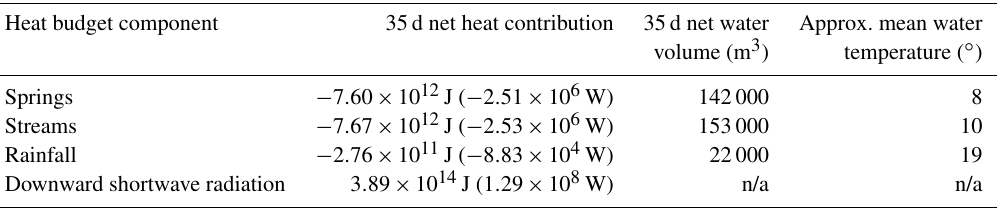
Figure 5. Simplified workflow and results describing the area and discharge analyses of Spring 8 (included in Table S2 and Fig. S6) using the Basin Head plume size–spring discharge relationship. (a) Raw thermal image of Spring 8 cropped (rectangular) to the spring area (maximum offset of 14 ◦ between the spring water and discharge environment; pixel resolution of 6cm per pixel). (b) Thermal image converted to 8-bit grayscale and cropped (polygonal) to thermal groups of interest. (c) Graph of thermal image pixel data in terms of cumulative area and binned grayscale values. The graphical analysis method of Roseen (2002) guided by manual inspection of image pixel values was used to define the plume area ( ∼ 115m 2 ). (d) The plume size–spring discharge relationship from the three gauged springs of the lagoon is used to define spring instantaneous discharge based on plume area defined in (c) . Panels (a) , (b) , (c) , and (d) in this figure correspond with box numbers 1, 1b, 1c, and 3, respectively, for Fig. S1 in the Supplement. Table 1. Basin Head lagoon heat fluxes associated with three advective processes and downwelling shortwave radiation applied across the lagoon surface area. All heat budget components are over the 35d focused study period. Positive values indicate an addition of sensible energy to the lagoon, while negative values indicate a cooling effect. Lagoon water temperature was approximated as its median value (22 ◦ ) to calculate the advective terms (Eq. 1). n/a: not